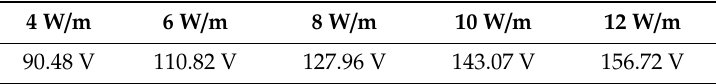
Table 4. Heating power and corresponding